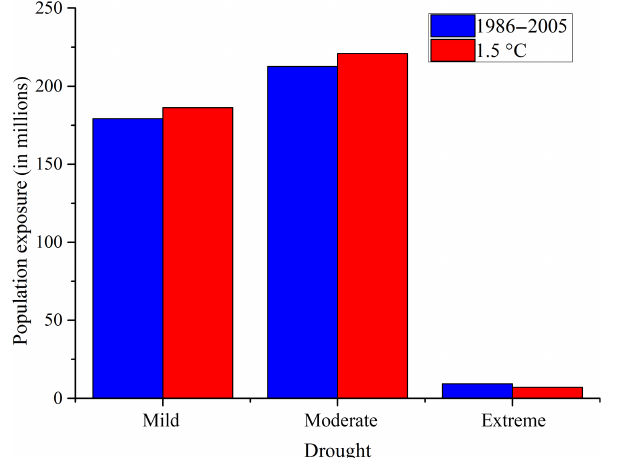
Figure 1. Population exposure to mild, moderate, and extreme droughts for the reference period (1986–2005) and 1.5 ◦ C global warming scenario (2020–2039 in